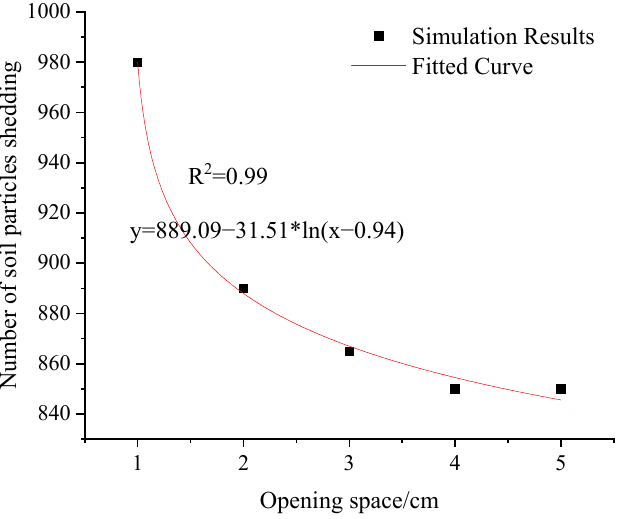
Figure 8. The effect of hole spacing on drainage shedding of soil particles.